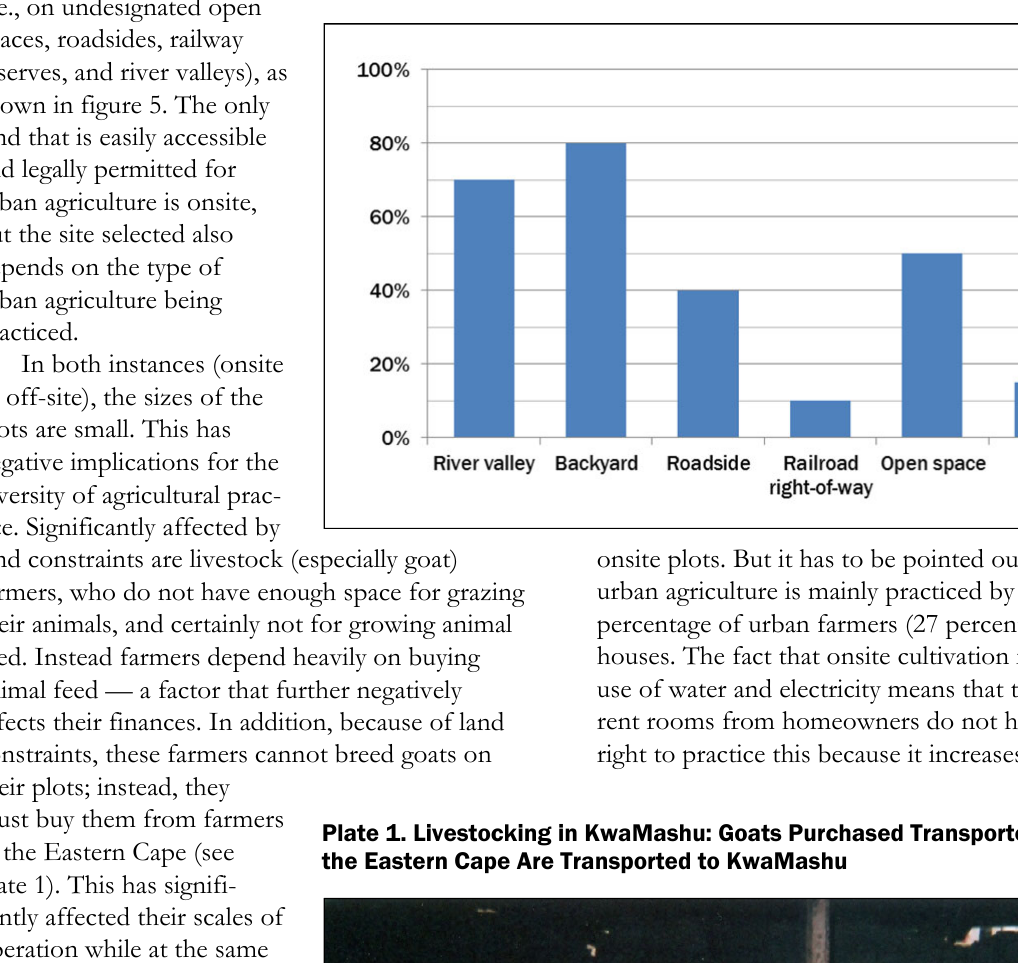
Figure 5. Distribution of Urban Agriculture Sites in KwaMashu (N=30)